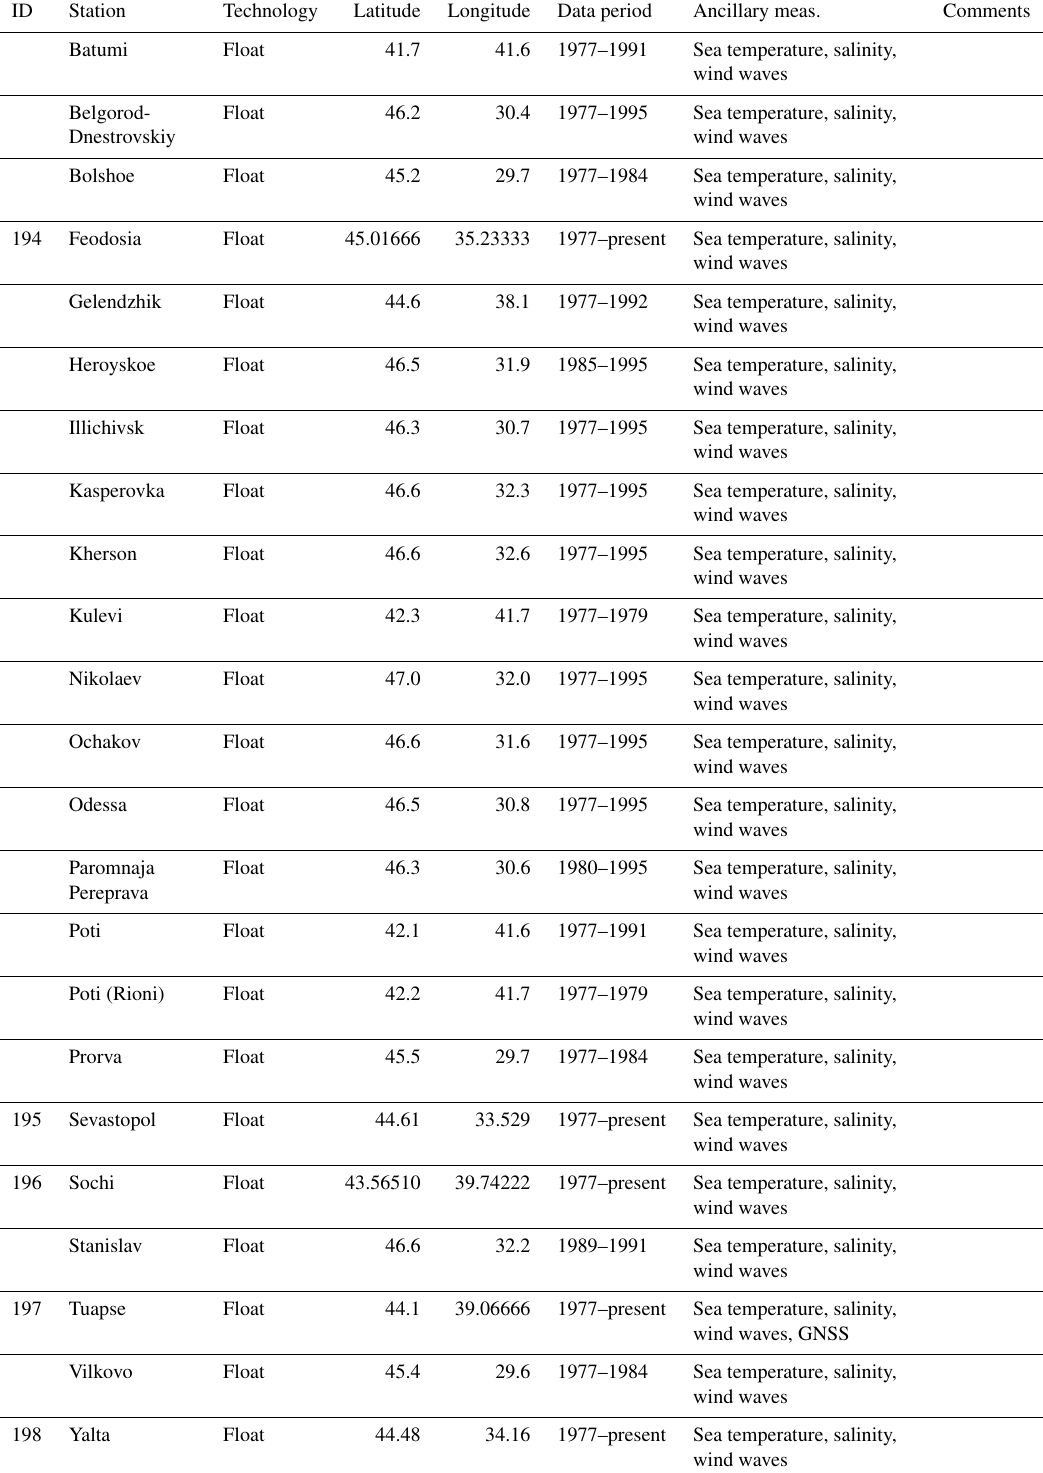
Table A20. North and north-eastern Black Sea tide gauge stations operated by the All-Russian Research Institute of Hydrometeorological Information – World Data